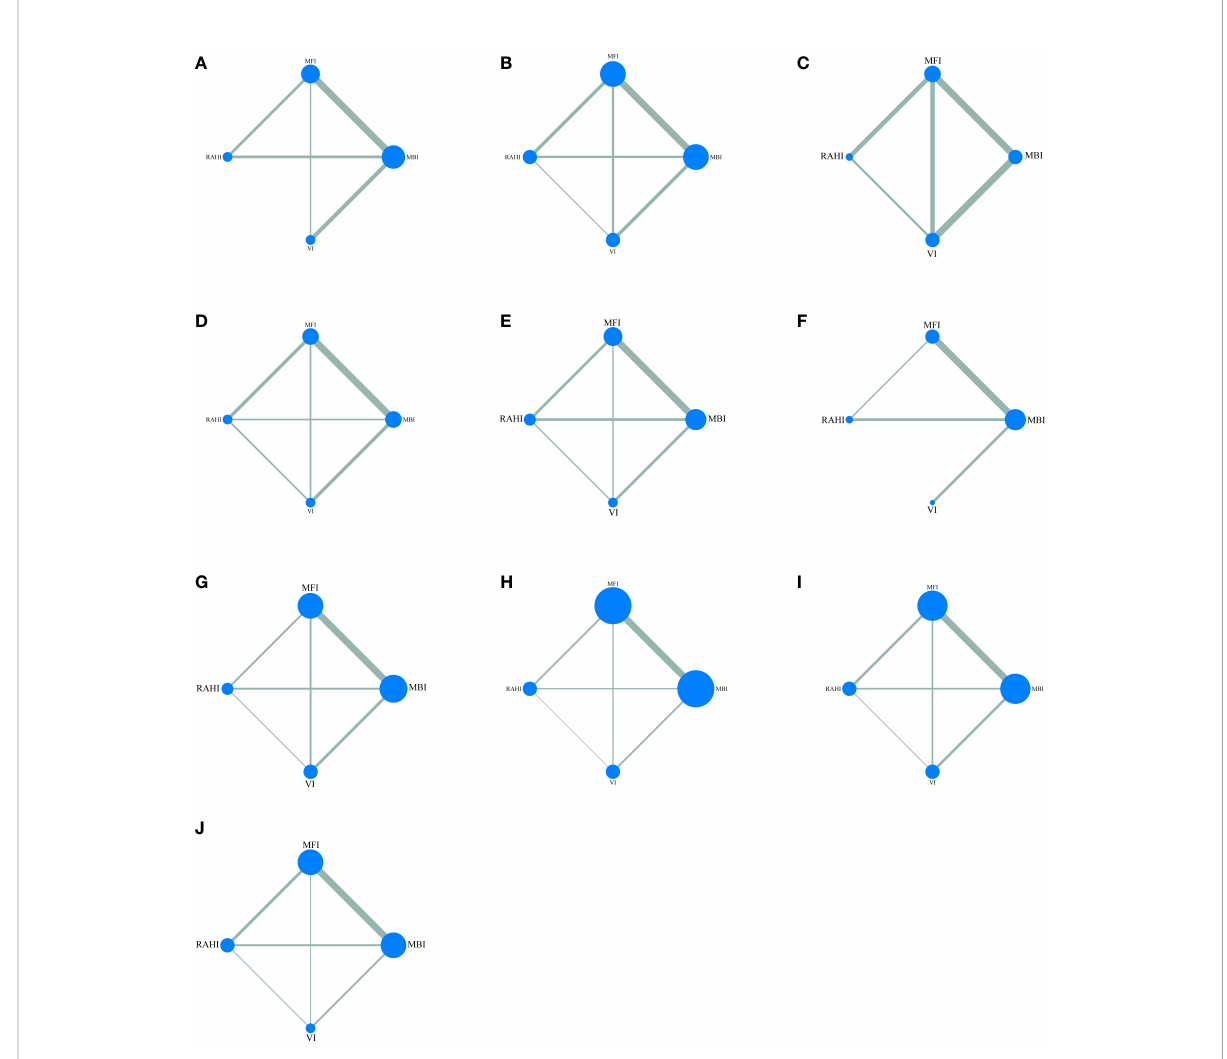
FIGURE 5 Network maps of all outcomes: (A) incision satisfaction score, (B) operation time, (C) drainage volume, (D) tumor size, (E) hematoma, (F) wound infection, (G) permanent facial palsy, (H) transient facial palsy, (I) salivary complications, (J) Frey